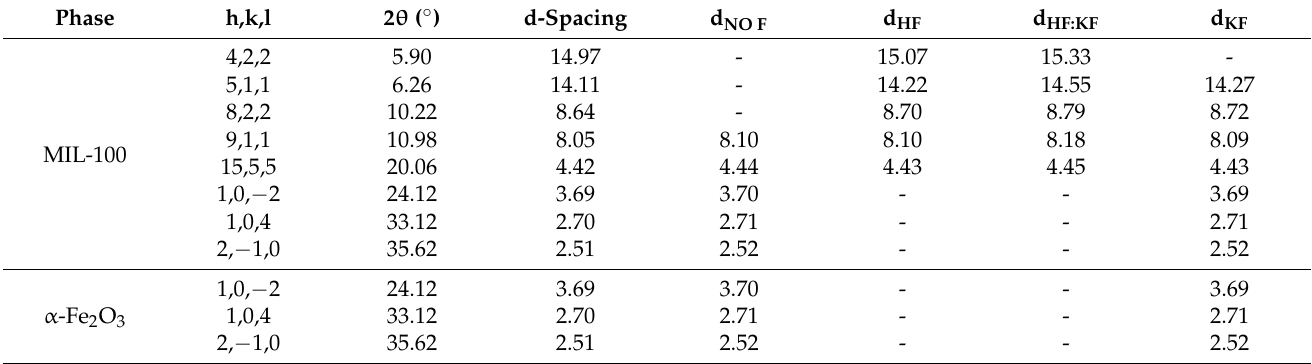
Table A1. Main characteristic peaks of the synthesized samples MIL-100(Fe) obtained using PDRX. The data are compared with results obtained by Horcajada [20] and Blake [53].